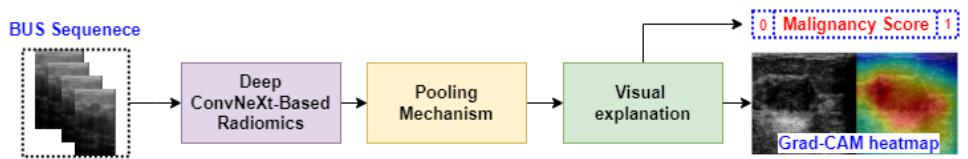
Figure 2. Overview of deep ConvNeXt-based radiomics for breast tumor malignancy prediction from BUS